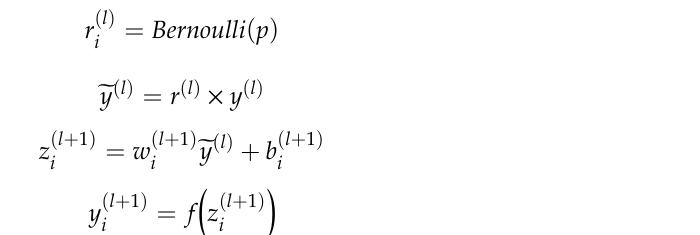
Figure 7. ( a ) The networks not using dropout; ( b ) the networks using dropout [38].